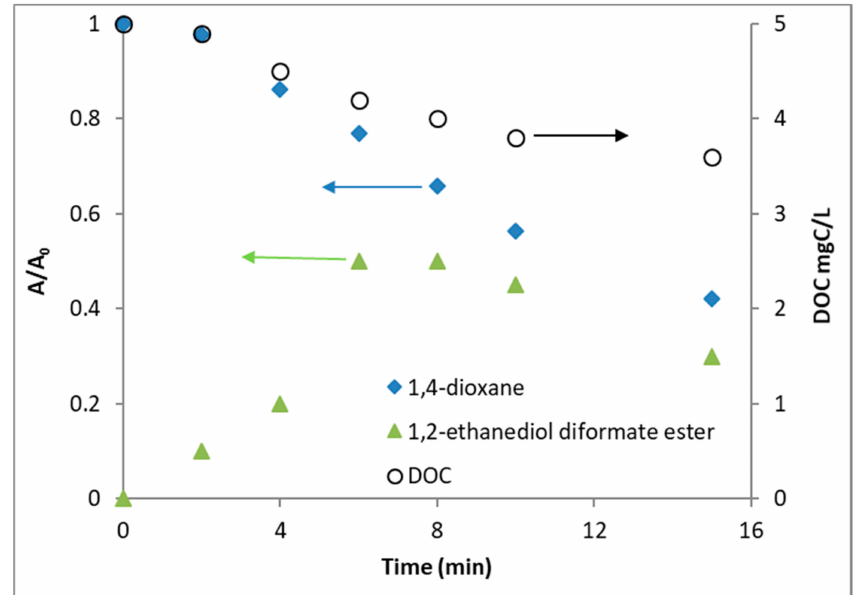
Figure 7. The MS peak areas for 1,4-dioxane and its main oxidation intermediate, normalized to the initial value of the peak area of 1,4-dioxane (t(0)), presented vs. time. Additionally, the DOC concentration from a separated experiment using initial 1,4-dioxane of 10 mg/L is also presented.